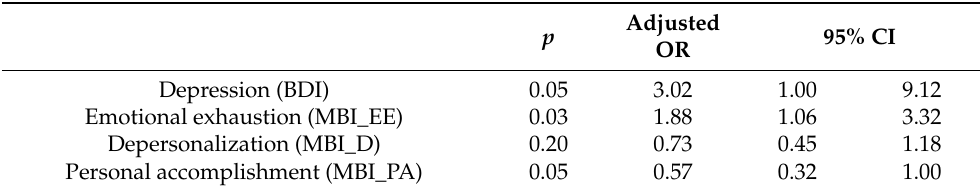
Table 4. Association of depression and burnout with hopeless status. Adjusted odds ratios and confidence